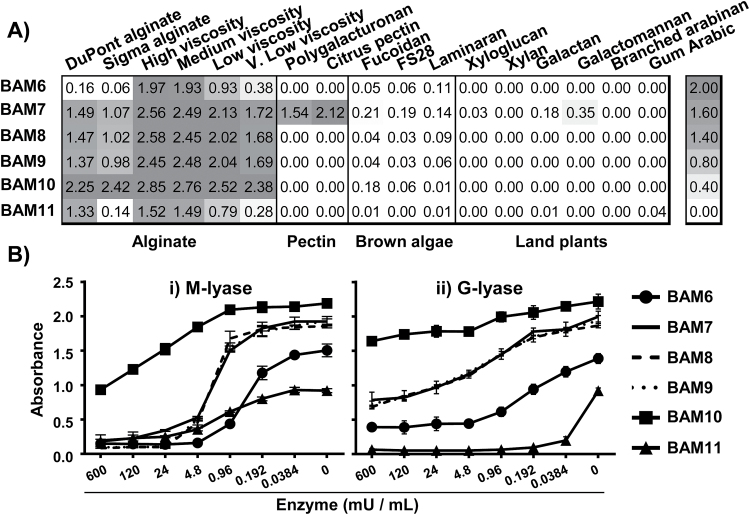
Characterization of six alginate-directed MAbs (BAM6–BAM11). (A) Heat map of epitope occurrence in a range of polysaccharides (coated at 50 µg ml–1) showing ELISA absorbance obtained from 25-fold dilution of MAbs. Values shown are means of four replicates and in all cases SDs were <0.1 absorbance unit. (B) ELISA analysis of loss of epitope recognition due to enzymatic cleavage of high-viscosity alginate via (i) M-lyase and (ii) G-lyase, with constant 25-fold dilution of MAbs. Note that BAM7, BAM8, and BAM9 are indistinguishable. Results are means of three replicates, and error bars represent the SD.